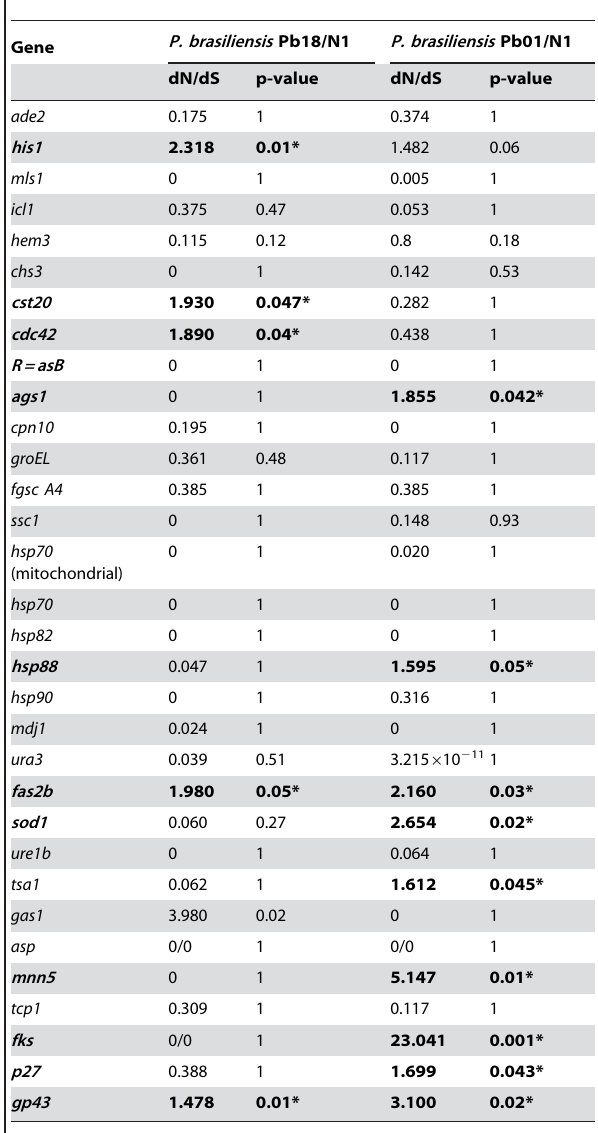
Table 1. Ratio of nonsynonymous to synonomous mutation rate (dN/dS) values for putative virulence factors in the